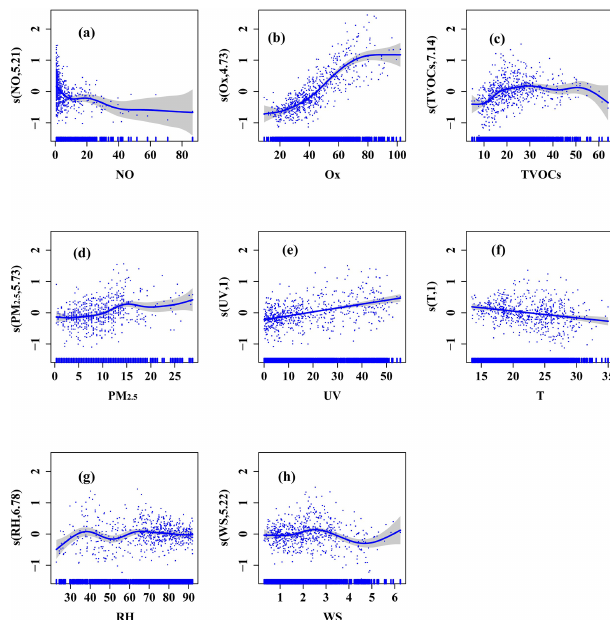
Figure 3. Response curves (spring) in the multiple-factor model of PAN to changes in (a) NO, (b) O x (O x = O 3 + NO 2 ), (c) TVOCs, (d) PM 2 . 5 , (e) ultraviolet radiation (UV), (f) air temperature ( T ), (g) relative humidity (RH), and (h) wind speed (WS). The y axis is the smoothing function values. For example, s (NO, df) shows the trend in PAN when NO changes, and the number of df is the degree of freedom. The x axis is the influencing factor, and the shaded area around the solid blue line indicates the 95% confidence interval of PAN. The vertical short blue lines represent the concentration distribution characteristics of the explanatory variables (units: NO (ppbv), O x (O 3 + NO 2 ; ppbv), TVOCs (ppbv), PM 2 . 5 (µgm − 3 ), UV (Wm − 2 ), T ( ◦ ), RH (%), WS (ms − 1